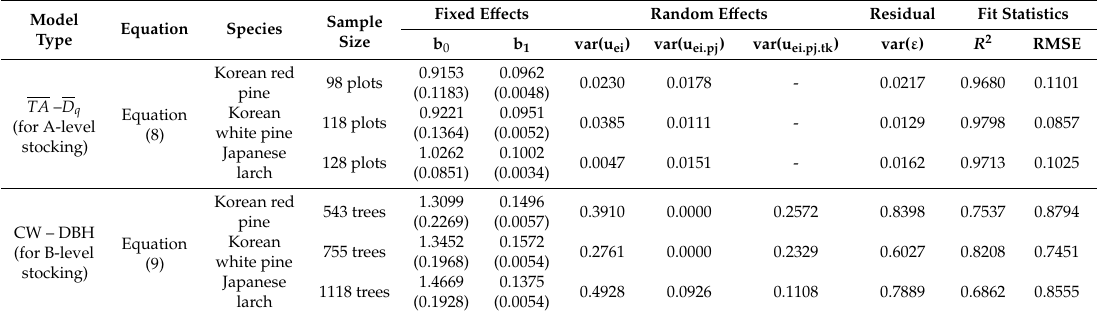
Table 2. Parameter estimates and fit statistics through tree allometric equations for A-level and B-level stocking by